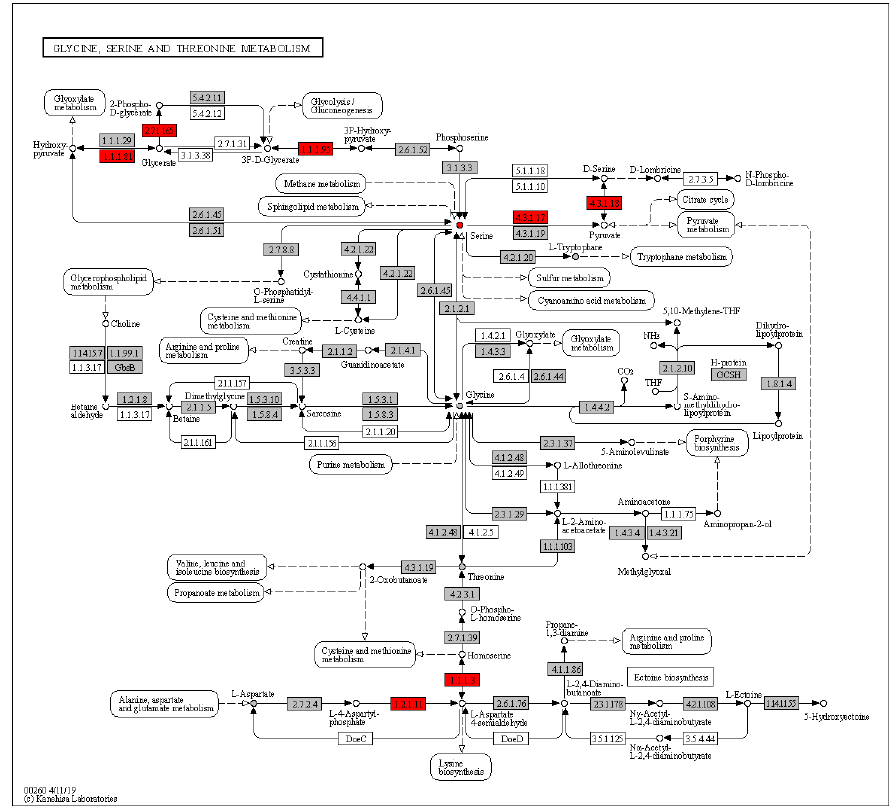
Figure 1. Glycine, serine, and threonine metabolic pathways. Circles represent compounds and rectangles are enzymes. The KEGG orthologs and metabolites that were significantly related with HCC are marked in red, otherwise in grey. are marked in red, otherwise in